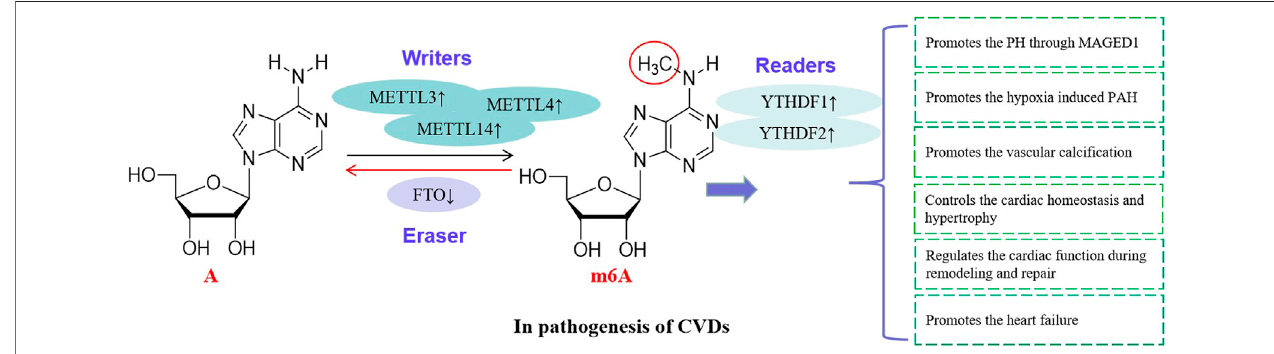
FIGURE3 | RNAmethylations areinvolved in the CVDs. RNA methylating enzymescatalyzethe methylationof m6A and are involved in the pathogenesis ofCVDs, suggesting that these enzymes are risk factors of CVDs.